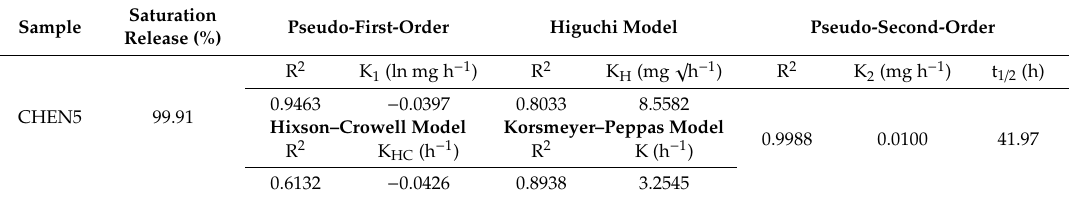
Table 2. The correlation coe ffi cients (R 2 ) and rate constant (K) obtained by fitting the hexaconazole release data from the CHEN5 in PBS solution pH